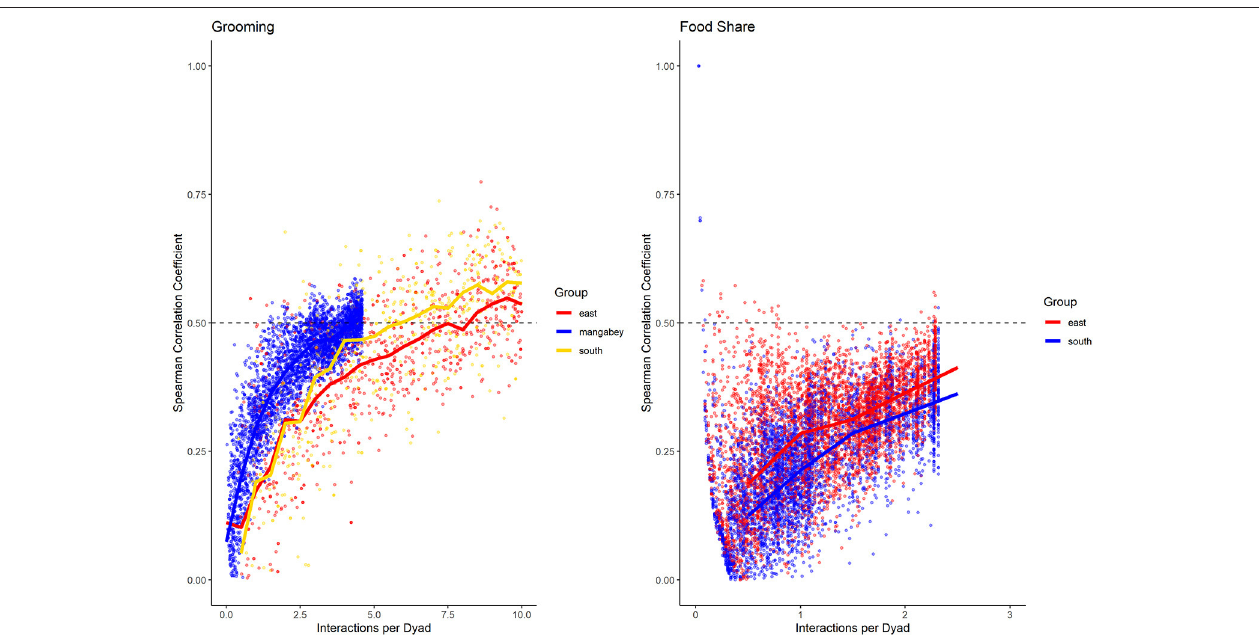
FIGURE 6 | Spearman correlation between two halves of randomly selected subsets of the datasets for mangabeys (blue), East chimpanzee community (red) and South chimpanzee community (golden) for grooming and food sharing (chimpanzees only). The standardized consistency is marked by the number of interactions per dyad where the median of correlation coefficients exceeds r = 0.5. If that value is reached with fewer interactions per dyad, the distribution of interaction rates is more consistent. Distributions of correlation coefficients with a large spread indicate changes in interaction preference over time.